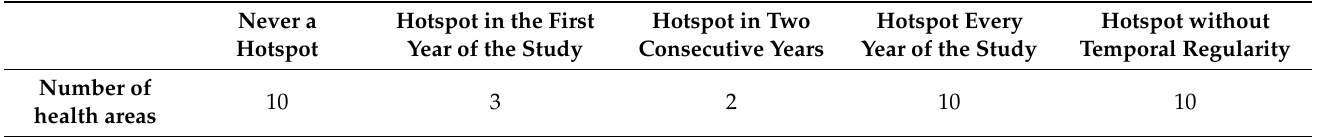
Table 2. Distribution of health areas according to hotspot